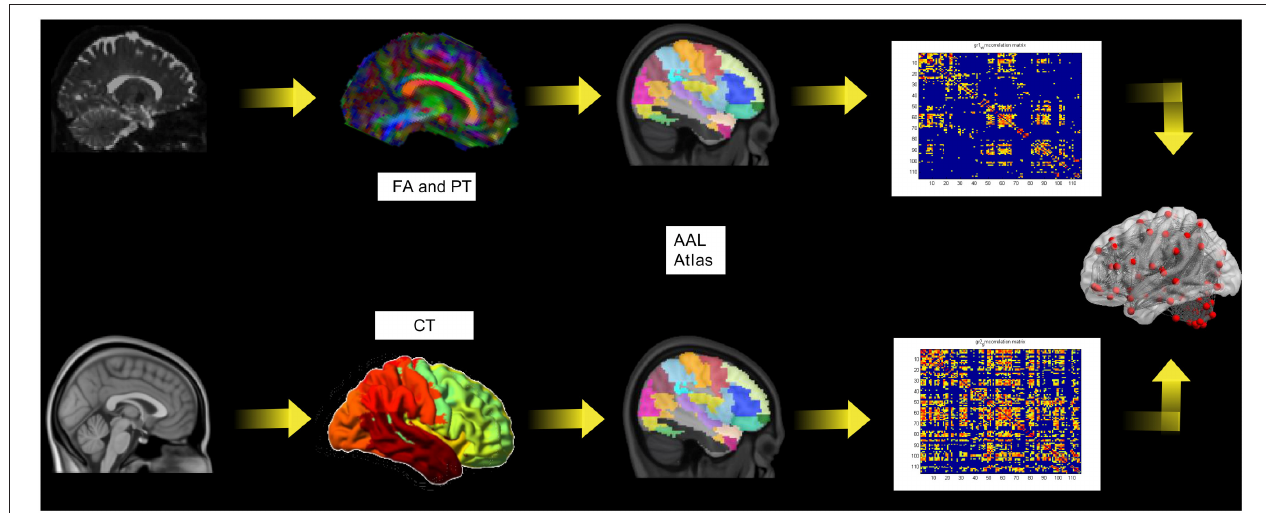
FIGURE 1 | The pipeline for the diffusion tensor imaging analysis including probabilistic tractography (PT) and fractional anisotropy (FA; upper row) and the cortical thickness (lower row).